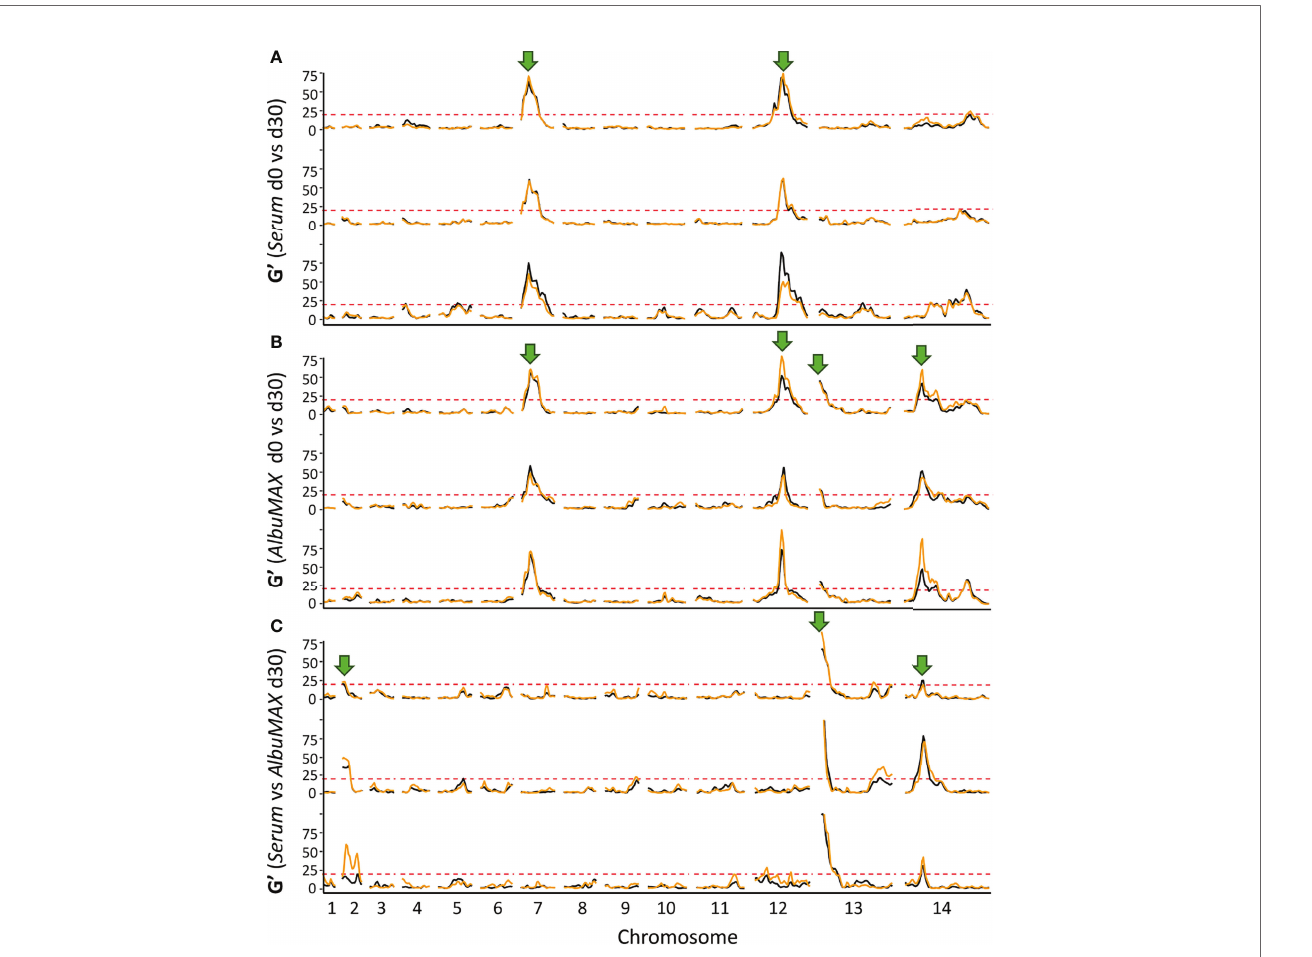
FIGURE 4 | QTLs de fi ned with the G ’ approach. The top (A) and middle (B) panels show QTLs detected by comparing allele frequencies from the initial recombinant pools and pools after 30 days of serum (top) or AlbuMAX (middle) culture. The bottom panel (C) indicates QTLs at day 30 when comparing serum and AlbuMAX cultures. There are three plots in each panel, representing analyses from the three recombinant pools (biological replicates). Orange and black lines delineate technical replicates in each experiment. We used a threshold (G ’ > 20) to determine signi fi cant QTLs. Arrows mark the position of QTLs identi fi